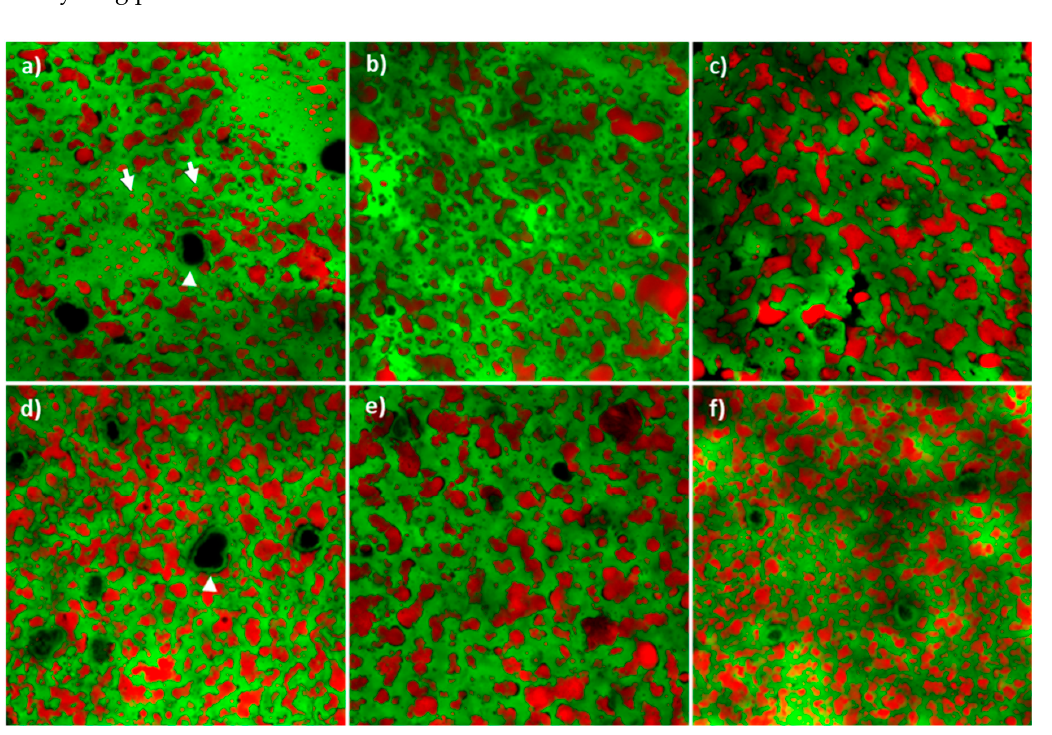
Table 4. Image analysis parameters (number of fat globules and porosity), hardness (N) and